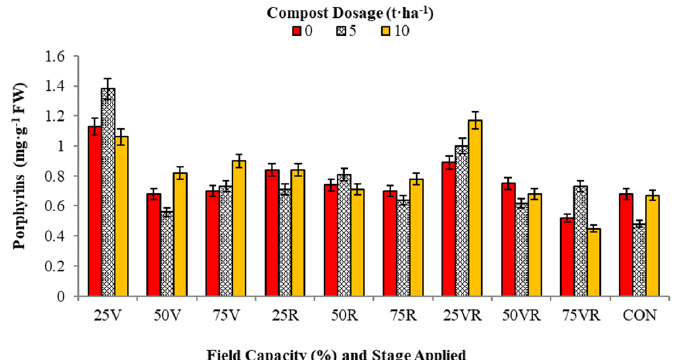
Figure 17. Effect of interaction of water regime, treatment stage and compost dosage on porphyrin content of okra leaf at 5 weeks The 25, 50 and 75% represent field capacity; V (vegetative), R (reproductive), and VR (vegetative and reproductive) represent the stage at which the deficit was applied. Data in the interaction analysed with Least Squares Means, and means separated with LSD.